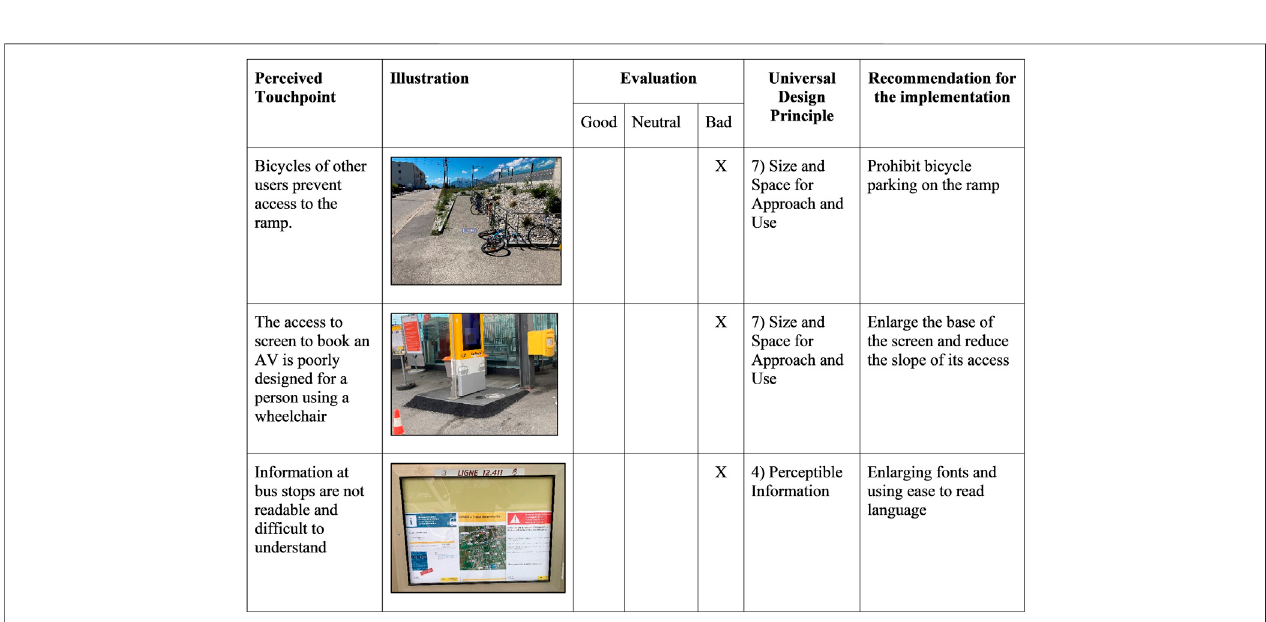
FIGURE 3 | Three examples of touchpoints and